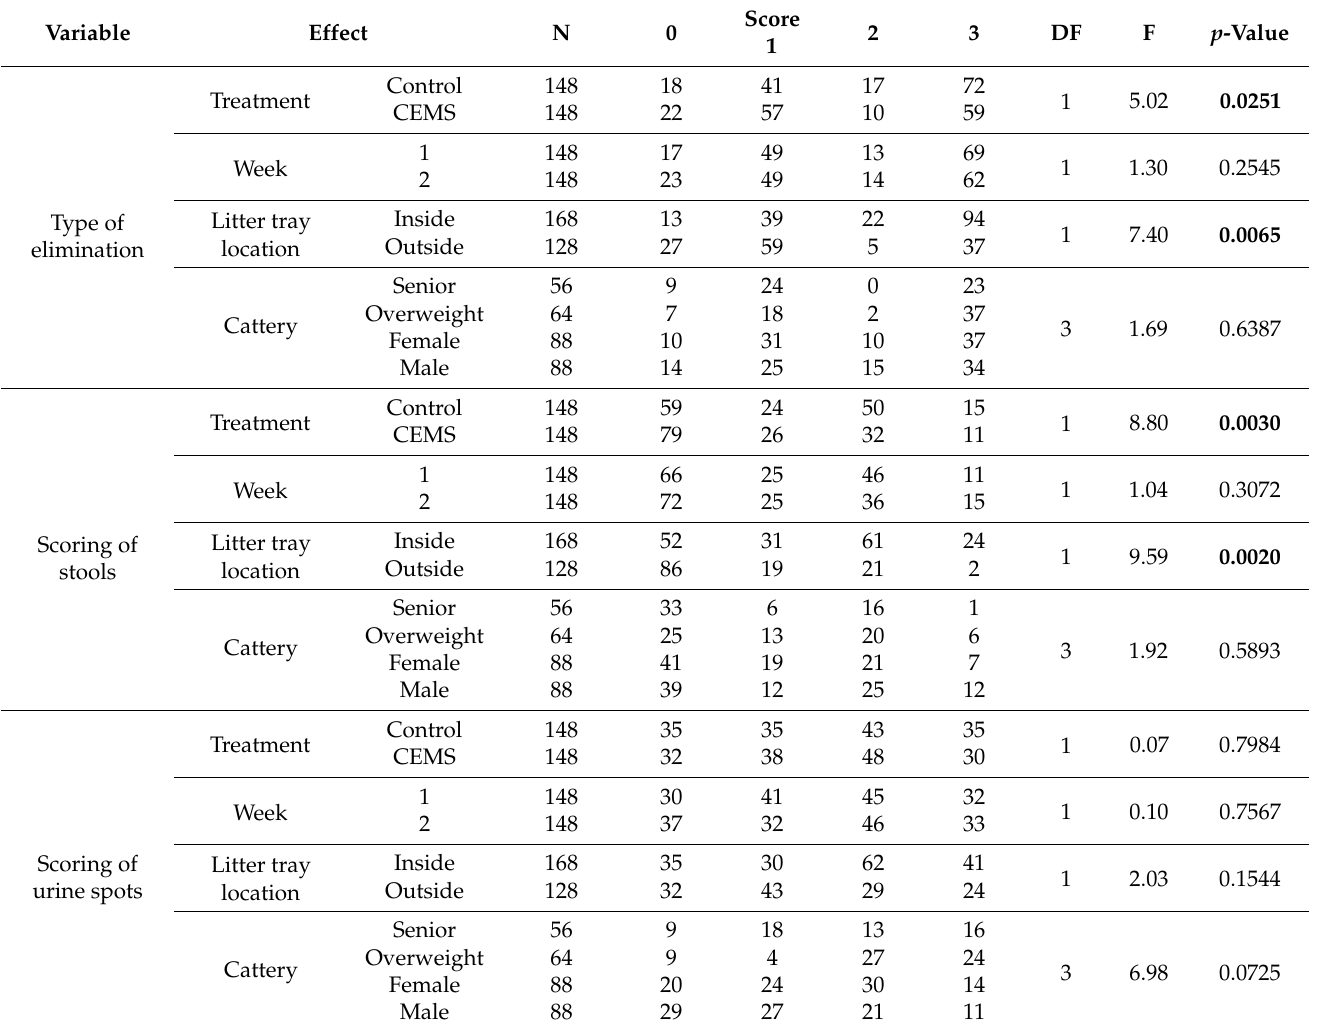
Table 3. Effect of treatment, week, litter tray location and cattery, on the type of elimination, scoring of stools and scoring of urine spots. For the type of elimination, score 0 = no elimination; 1 = urine only; 2 = stools only; 3 = urine plus stools. For the scoring of urine spots and stools, score 0 = no stool or urine spot; 1 = one to two stools or urine spots; 2 = two to three stools or urine spots; 3 = more than three stools or urine spots. Significant differences are highlighted in bold